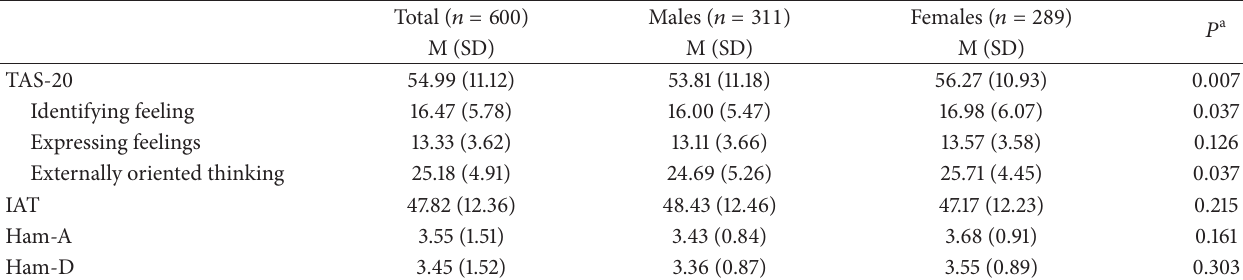
Table 2: Descriptive statistics of alexithymia, Internet addiction, anxiety, and depression test scores by